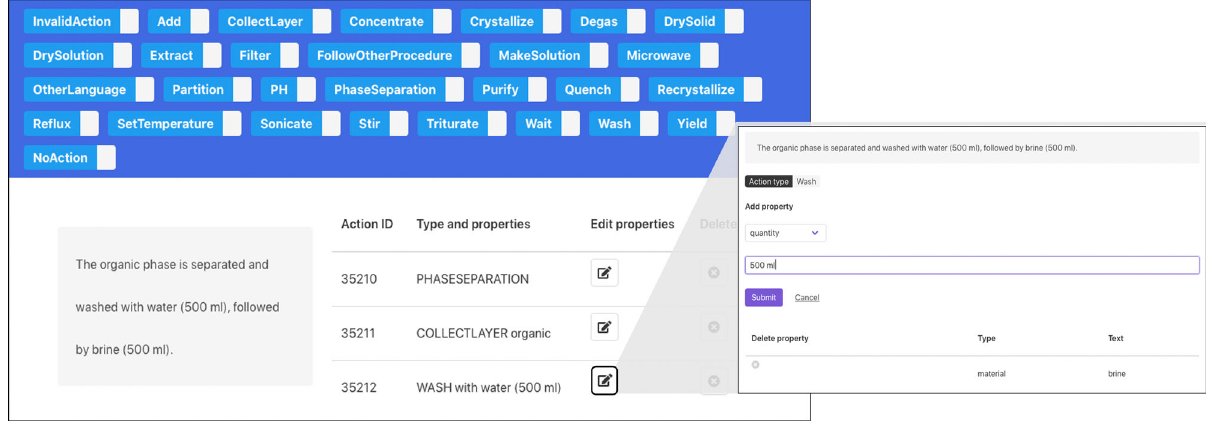
Fig. 4 Screenshots for adding and editing actions with the annotation framework. The sentence to annotate is displayed on the left-hand side, with the corresponding pre-annotations on the right-hand side. A Wash action is missing and can be added by clicking on the corresponding button at the top. Also, when clicking on the appropriate button, a new page open to edit the selected action. Table 6 Illustration of the data augmentation